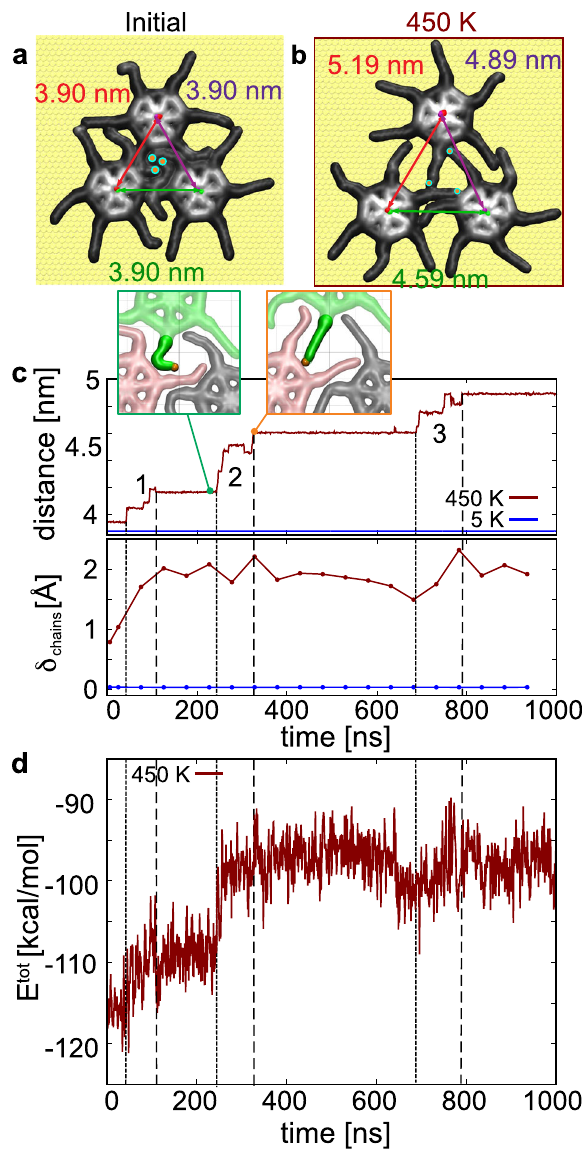
Fig. 4 In fl uence of chain mobility on the thermoresponse of a SW trimer. a , b Atomic con fi gurations of the SW trimer initially ( a ), and after 1 μ s long MD simulation at 450 K ( b ). c Time-evolution of the average distance between the molecule cores (top) and chain fl uctuations (bottom). The insets are MD snapshots before and after expansion event 2 occurring at 450 K. d Time-averaged evolution of the total energy of the SW trimer during the MD simulation at 450 K.